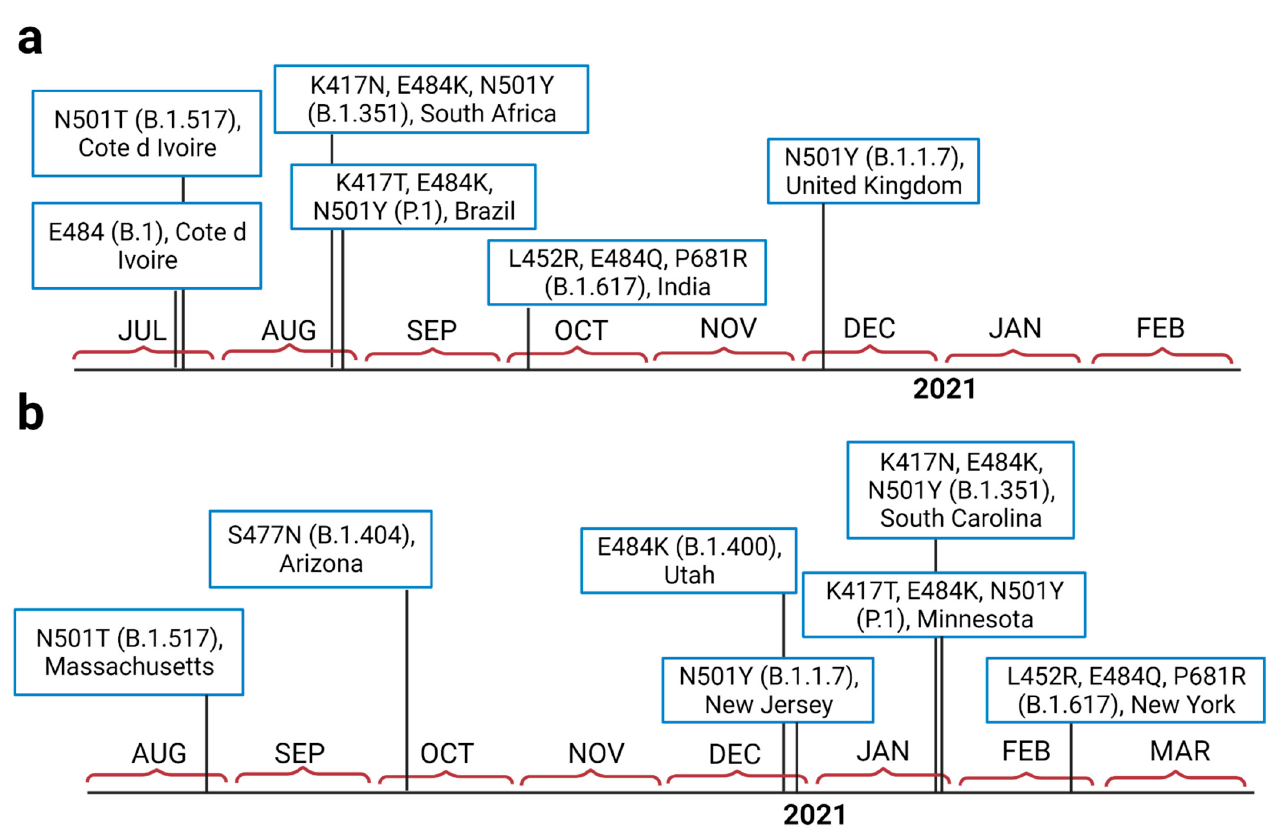
Figure 1. The isolation timeline of currently important emerged variants of SARS-CoV-2in the world ( a ), and in the U.S. ( b ).